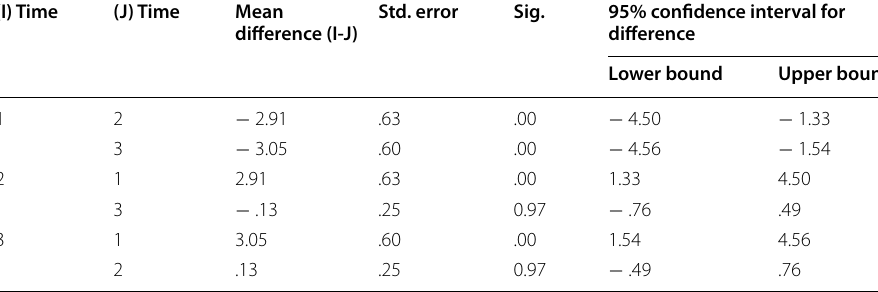
Table 8 Pairwise